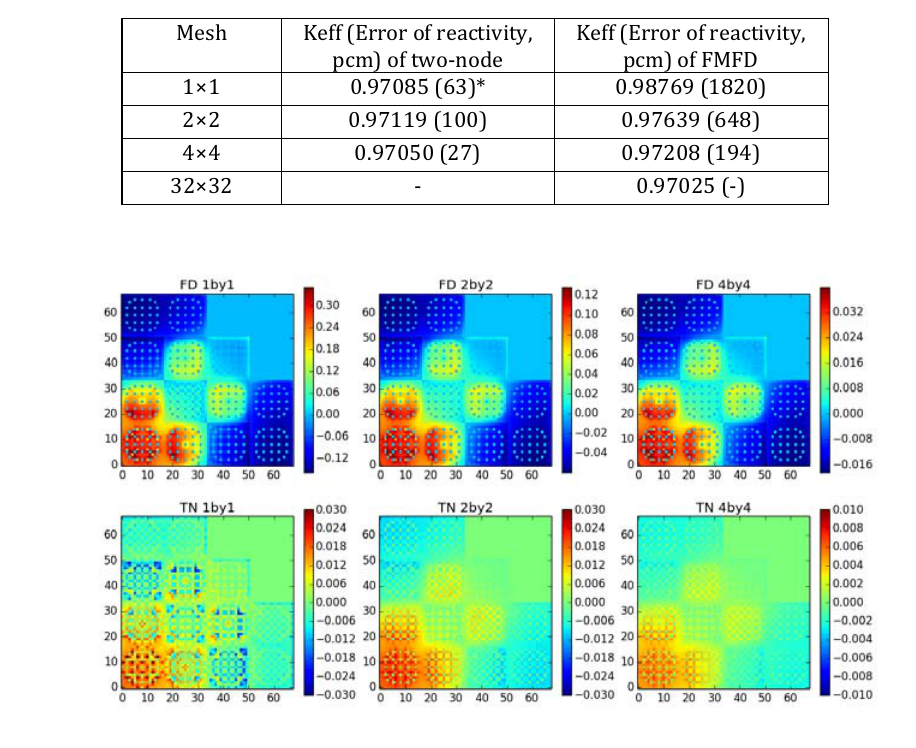
Figure 3. Relative Error of Power of KAIST 3A Benchmark